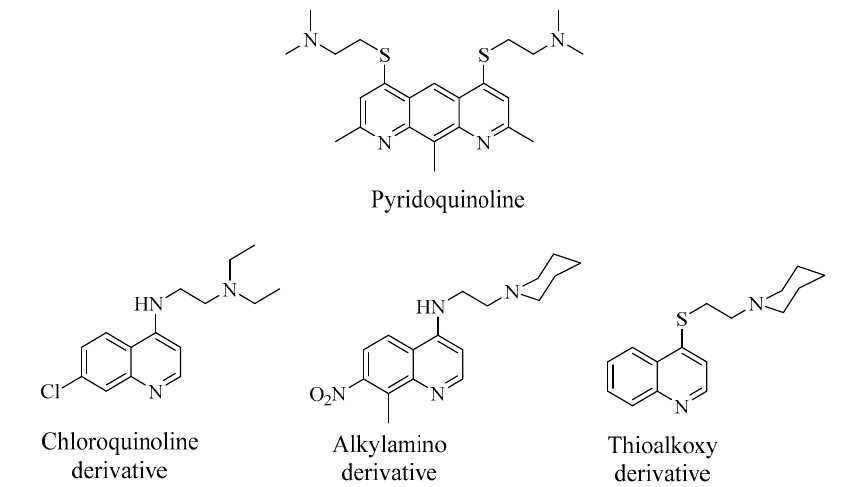
Figure 8. Quinoline derivatives investigated as EPIs against multi-drug resistant (MDR) E. aerogenes